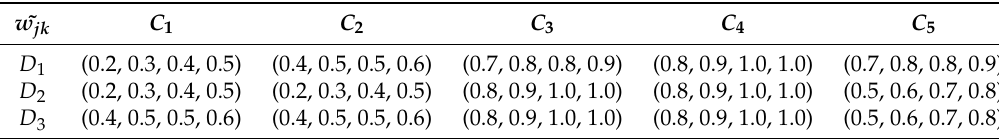
Table 2. A set of fuzzy importance weights ˜ W k